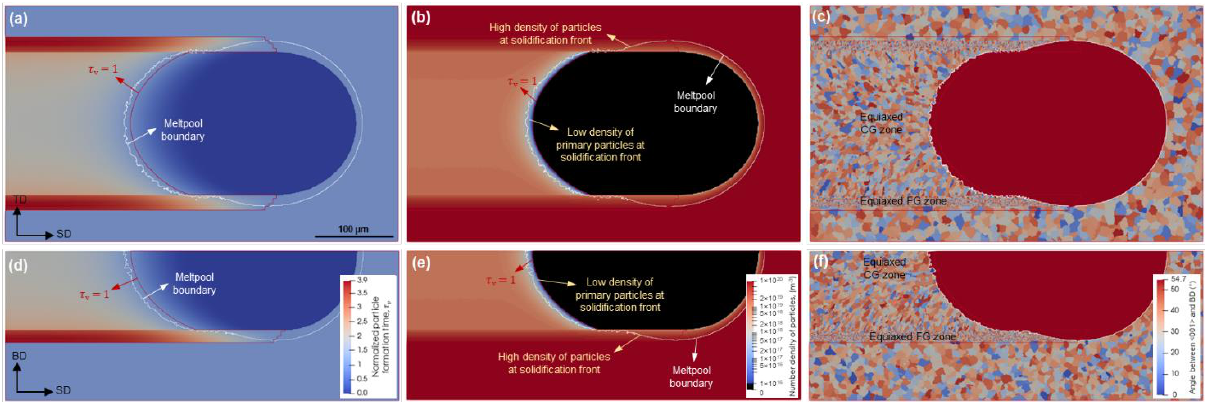
Figure 9. CA simulations of particle and microstructure evolution at a scanning speed of 500 mm/s and a platform temperature of 298 K; distributions of normalized particle formation time 𝜏 𝑣 ( a , d ), particle number density ( b , e ), and resulting grain structure ( c , f ) on the top surface ( a – c ) and the longitudinal cross-section ( d – f ).